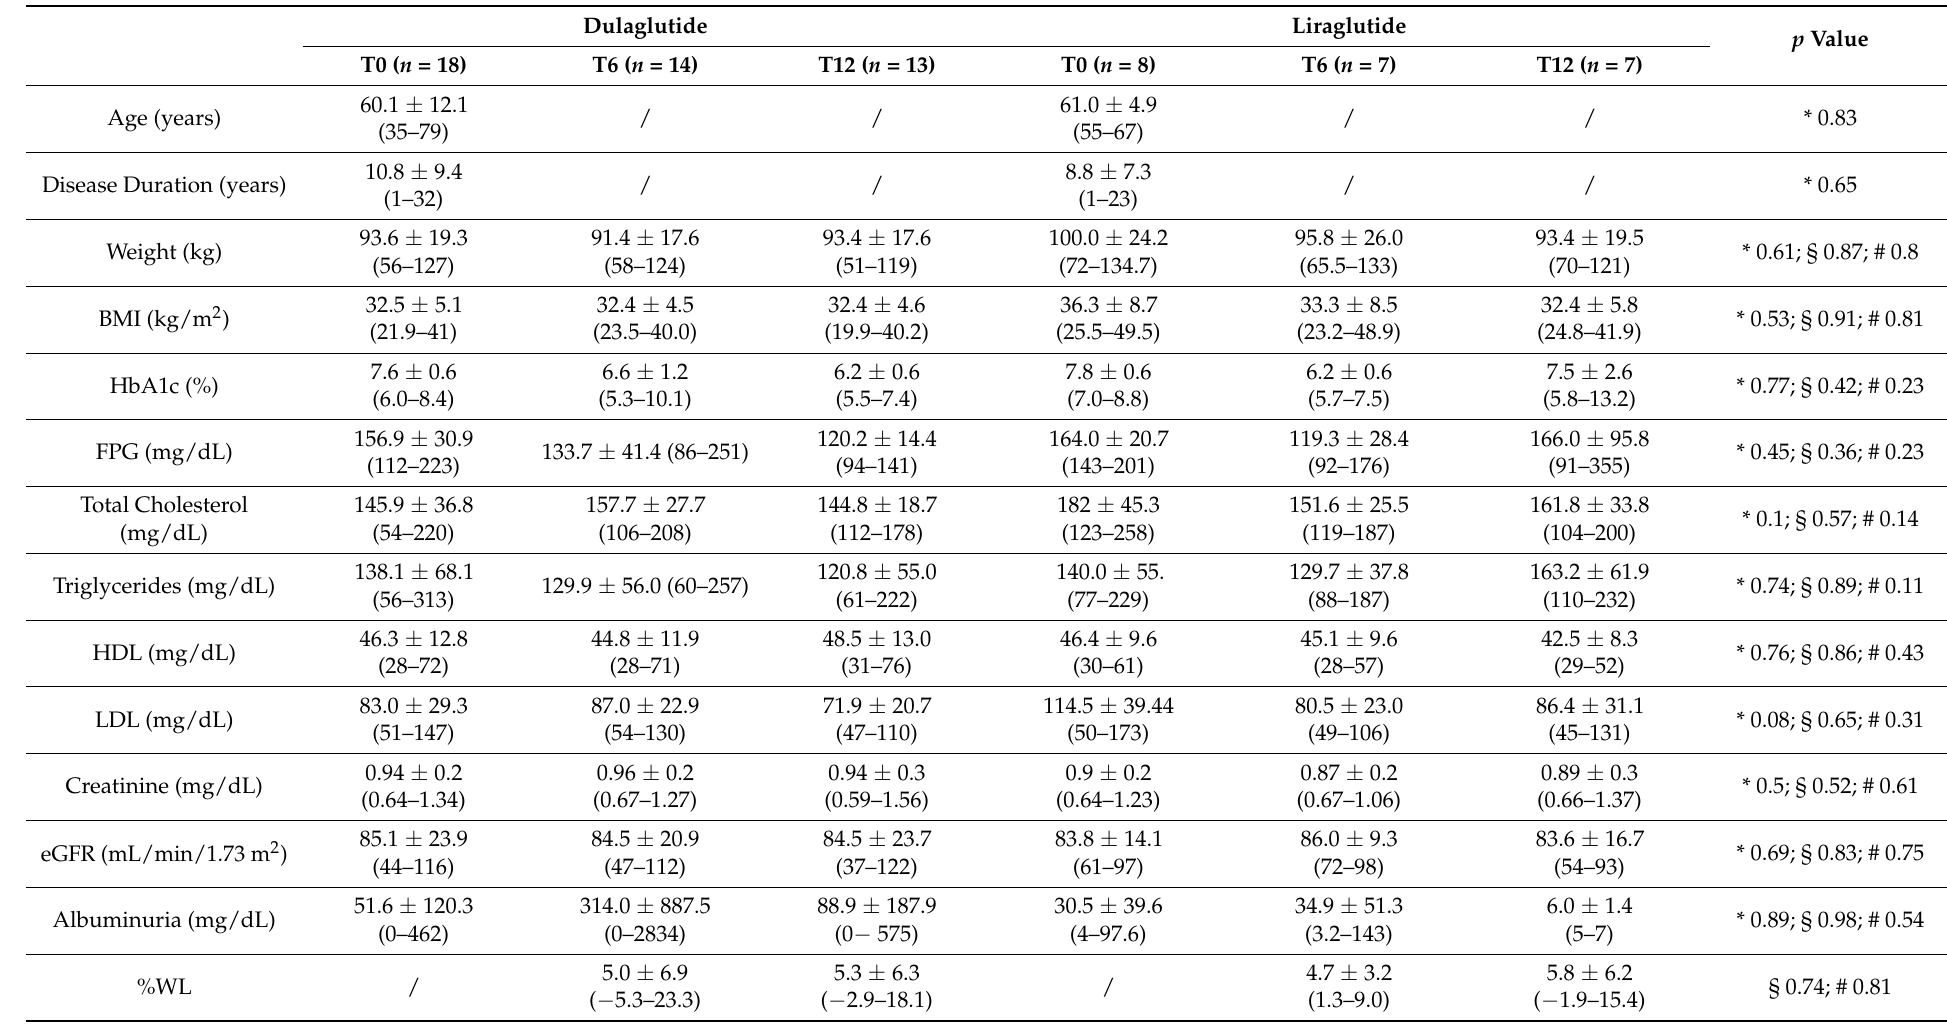
Table 2. Anthropometric measures and metabolic data in patients treated with dulaglutide or liraglutide, before and after